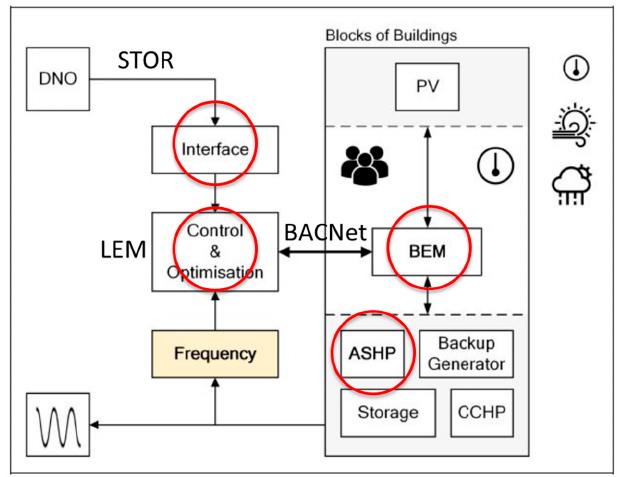
Figure 3. Control concept for handling STOR event at the UK pilot site. Buildings 2018 , 8 , x